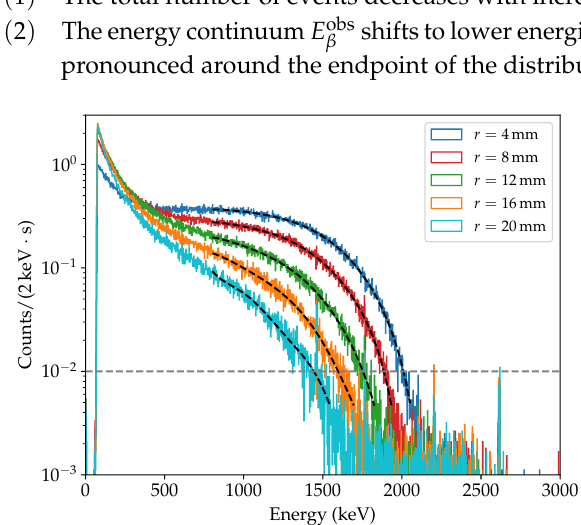
Figure 13. Background-subtracted energy spectra E obs correspond to polynomial fits to the spectra. The endpoint was approximated by determining the intersection of the fits with a fixed value (grey dashed